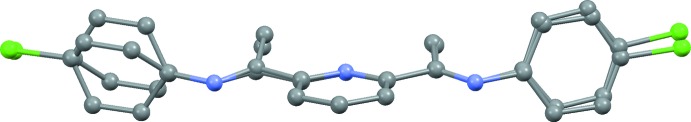
View of the mol­ecular overlay of the two independent mol­ecules.